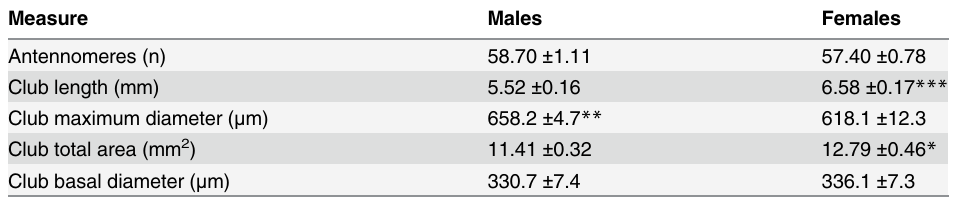
Table 1. Number of antennomeres and club measurements for the Paysandisia archon antennae.